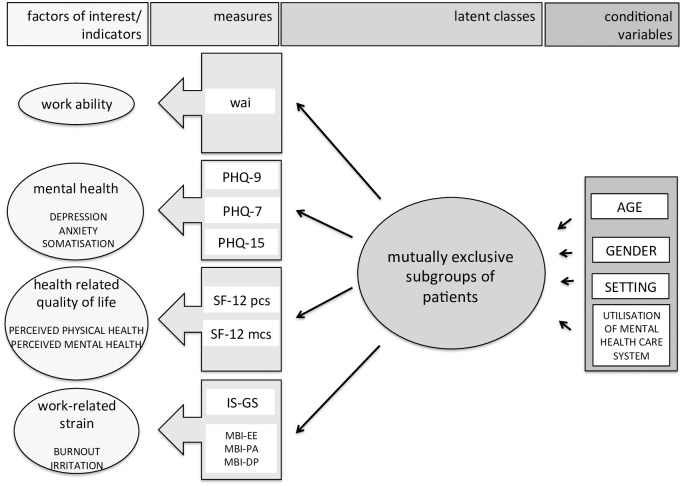
Conditional latent profile model.Factors of interest as continuous variables. Measures by the instruments WAI = work ability index, PHQ-9 Patient health questionaire 9 Items—depression, PHQ-7 Patient health questionaire 7 Items—anxiety, PHQ-15 Patient health questionaire 15 Items—somatoform symptom severity, SF12 = Health related quality of life, pcs = physical component score, mcs = mental component score, IS-GS = Irritations scale, global score, MBI = Maslach Burnout Inventory, EE = emotional exhaustion, PA = personal accomplishment, DP = depersonalisation.